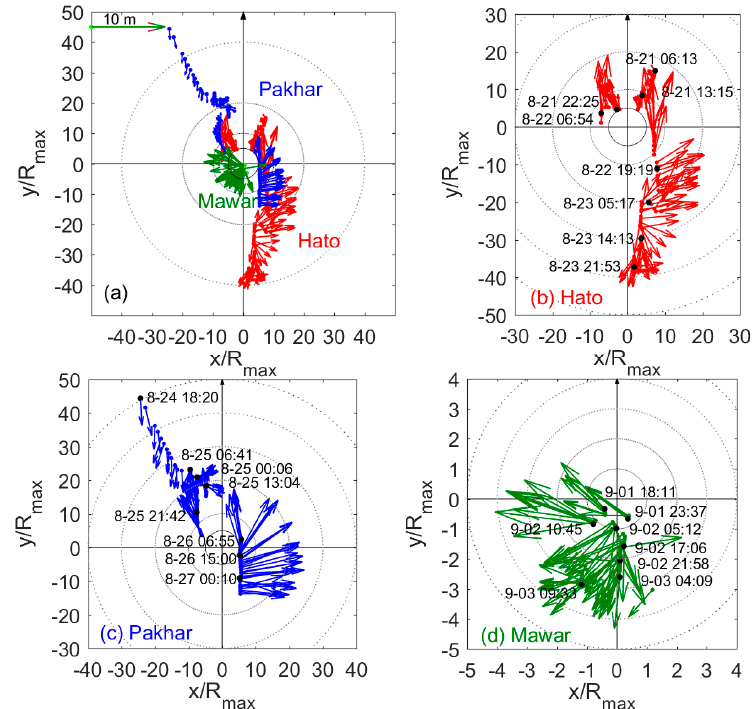
Figure 6. The vector directions indicating the mean wave directions for the wave glider data during the three typhoons (only when TC wind speed larger than 17.2 m/s). The vector length indicates the significant wave height. Wave glider positions are indicated by dots. All data are plotted in the moving coordinated system with the origin at the typhoon center and the y-axis in the typhoon’s propagation direction. The dashed circles represent the different times of the maximum wind speed radius ( R max ). The system is shown in the Northern Hemisphere (i.e., anti-clockwise circulation) ( a – d